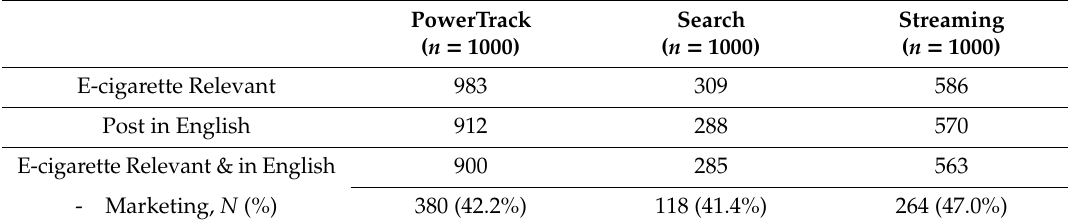
Table 2. Random samples of Twitter user accounts from each of the APIs.